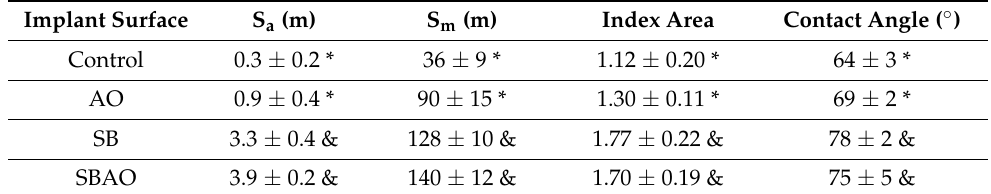
Table 3. Roughness and contact angles of the different mini-implants in the four OMIs groups: as-machined (Control), anodic-oxidation (AO), sandblasting (SB), and sandblasting and anodic- oxidation (SBAO). The results with the same symbol (* and &) do not present significant statistical differences ( p <